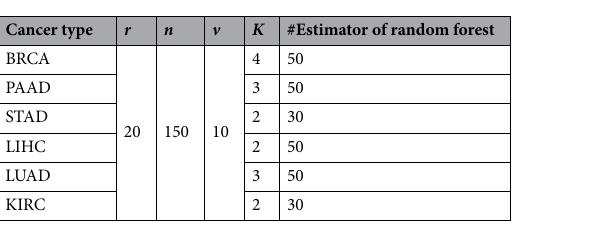
Figure 2. The fivefold cross validation results for finding optimal parameters. (a) Ratio of nodes selected for reconstruction of FI network ( r ), (b) number of genes to select ( n ), (c) size of gene vector ( v ).